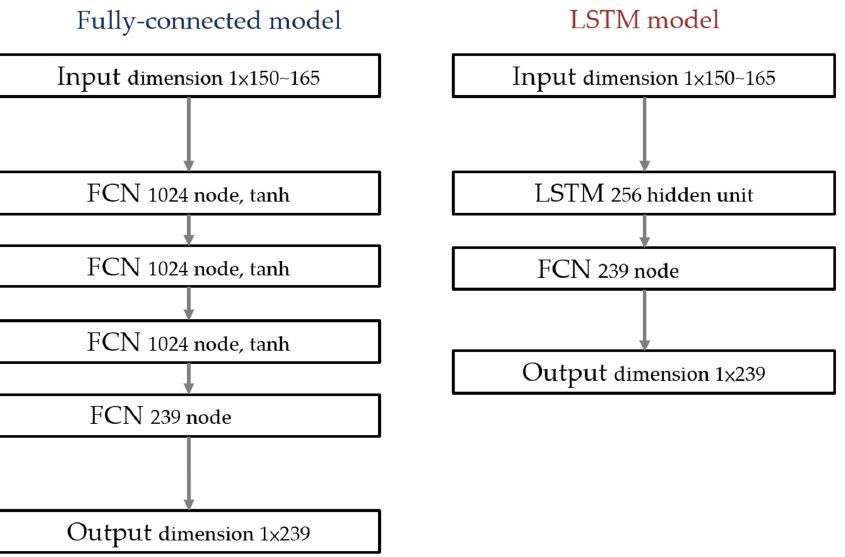
Figure 2. Models used in cross-validation over data from the same pigs as in Part II. ( Left ): The fully connected model used in this study; ( right ): the LSTM model used in this study. The input size ranged from 1 × 150–165 depending on the ECG recording vest used for the different pigs.